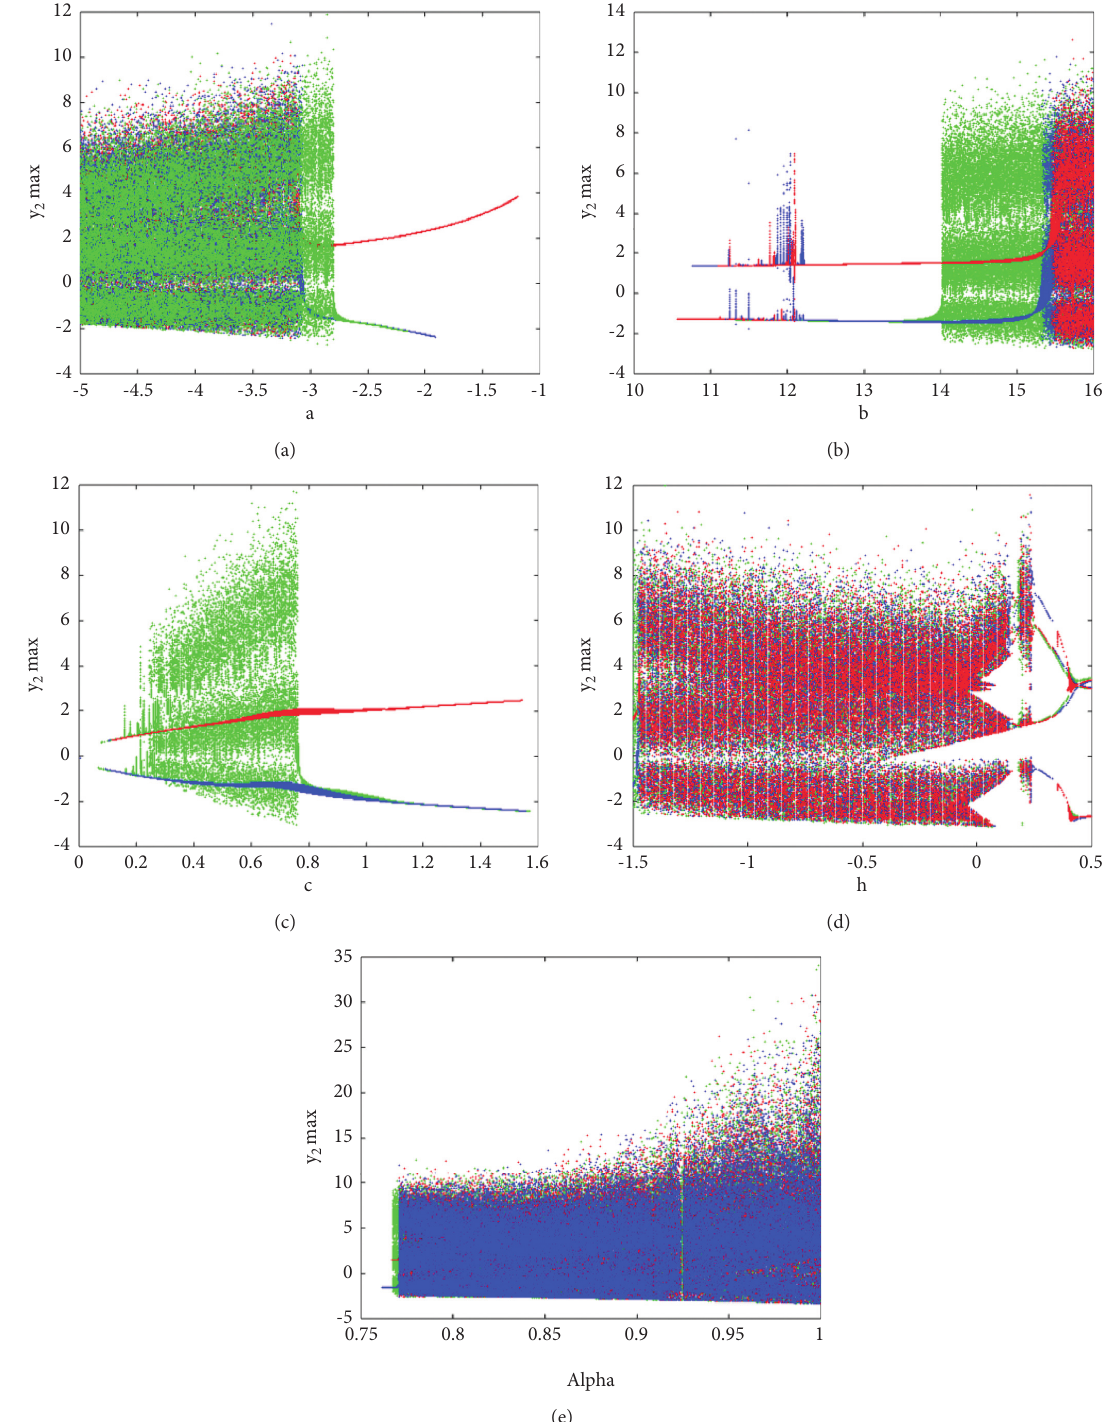
Figure 5: The bifurcation diagrams of the fractional-order Matouk’s system with varying system’s parameters, using the parameter set A and α � 0 . 77 and initial conditions ( 0 . 1 , 0 , 1 , 0 . 01 ) (green plot); ( 3 , 1 , 15 , 0 . 0199 ) (red plot), and (− 3 , − 1 , 15 , 0 . 0199 ) (blue